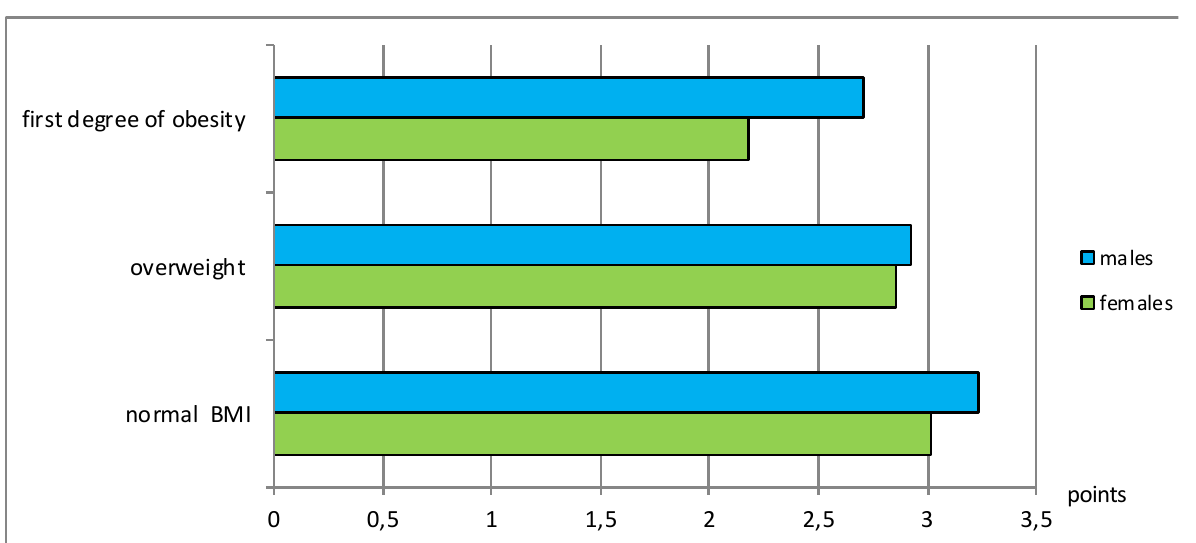
Fig. 5. Integrated criterion of physical fitness level of females and males with different BMI